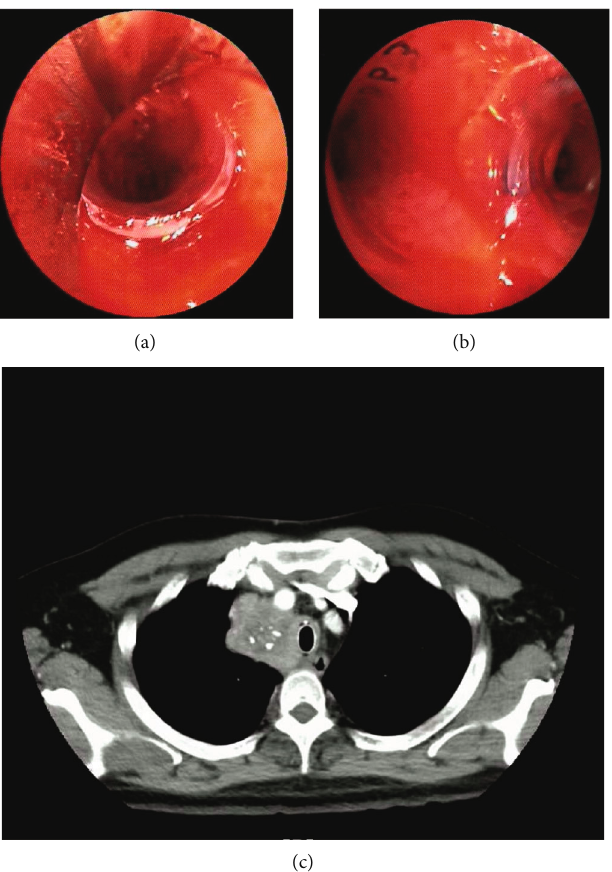
Figure 2: Bronchoscopy and thoracic-computerized tomography view of silicone Y-stent insertion. (a) Bronchoscopy view of silicone Y- stent at the subglottic trachea. (b) Bronchoscopy view of silicone Y-stent at the main carina. (c) Axial-computerized tomography view of airway stent at trachea. Arrow shows the airway stent; dotted arrow shows the thyroid